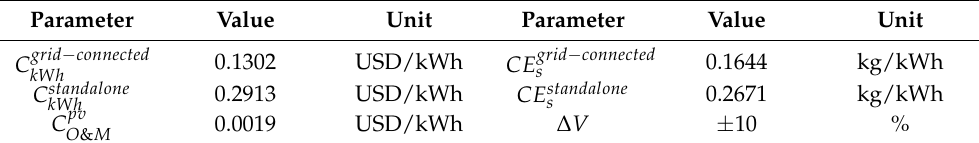
Table 7. Parameters used to calculate the economical, technical, and environmental indexes. Parameter Value